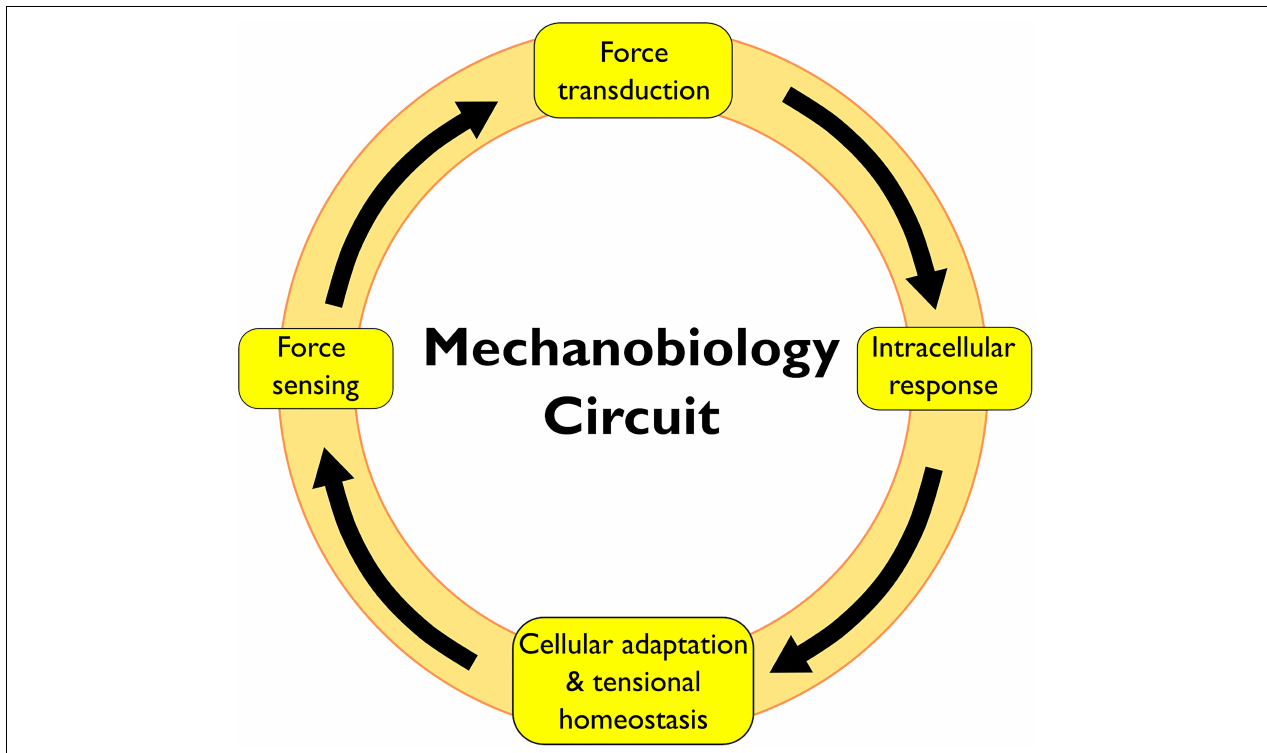
FIGURE 1 | Schematic of a mechanobiology